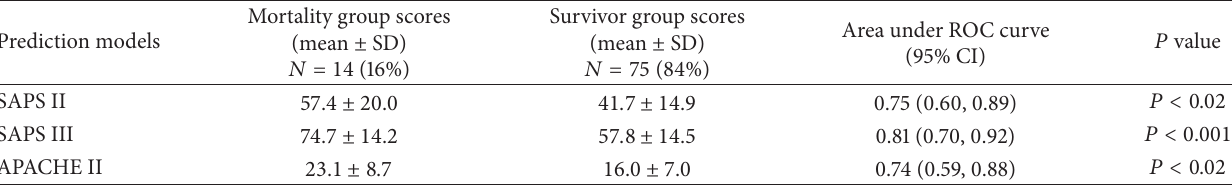
Table 3: Comparison of ICU mortality prediction models based on mean score and area under the receiver operator curve for 89 nonagenarians admitted to surgical ICU between 2000 and